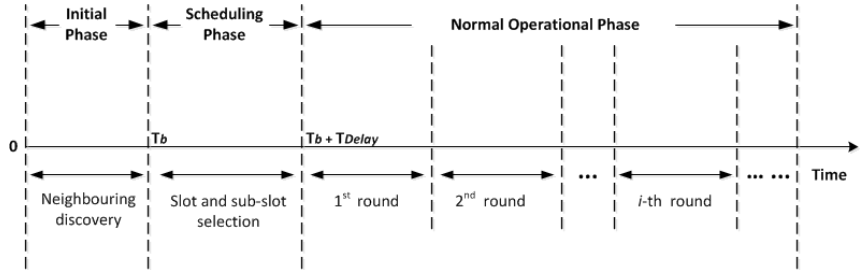
Figure 3. Timeline of ED-MAC